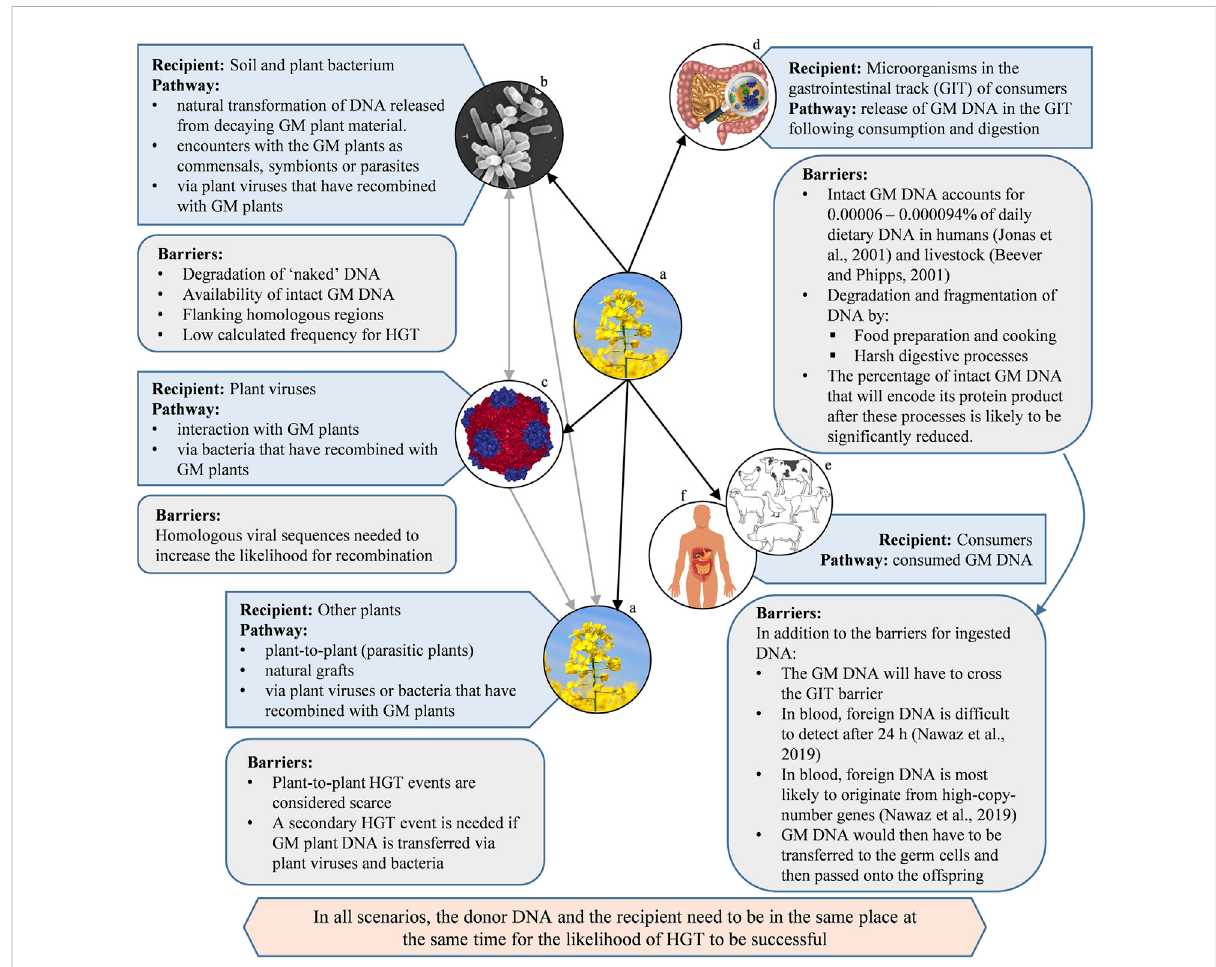
FIGURE 2 A selection of pathways and barriers for the horizontal gene transfer (HGT) from (GM) plants to a selection of recipients. Black arrows indicate directHGT,greyarrowsindicateasecondaryHGTeventfromplantvirusesand/orbacterium.[Imagescourtesyof: (A) canolabyPixabay/Jen ő Szabó, (B) Agrobacterium byJingXu,IndianaUniversity, (C) Cowpeamosaicvirus,PDBID:1NY7(Linetal.,1999),createdusingNGLviewer(Roseetal.,2018) at RCSB PDB, (D) , (E) and (F) sourced from